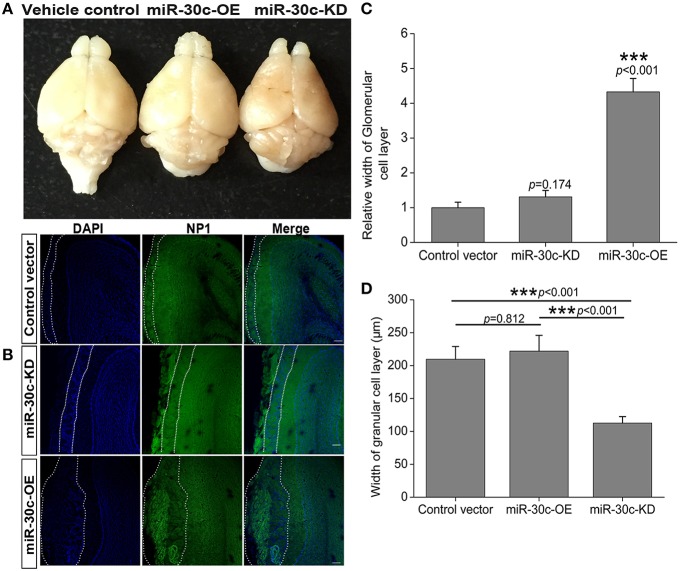
Morphological alteration of the OB induced by changes of miR-30c level in the SVZ. (A) The whole morphologies of OB 3 months after stereotaxic injection in the SVZ, n = 3 mice/group. (B) The glomerular cell layer and granular cell layer detection. Nuclei were stained by DAPI; Neuropilin-1(the receptors of semaphorin3A) expressed cells were stained with neuropilin (NP1). Regions between two dash lines were glomerular cell layer. Scale bar, 40 μm. (C) Statistic analysis width of glomerular cell layers. ***p < 0.001 determined by one-way ANOVA followed by Bonferroni multiple comparison tests. (D) Statistic analysis width of granular cell layers. ***p < 0.001 determined by one-way ANOVA followed by Bonferroni multiple comparison tests; n = 60 sections, four mice/group.